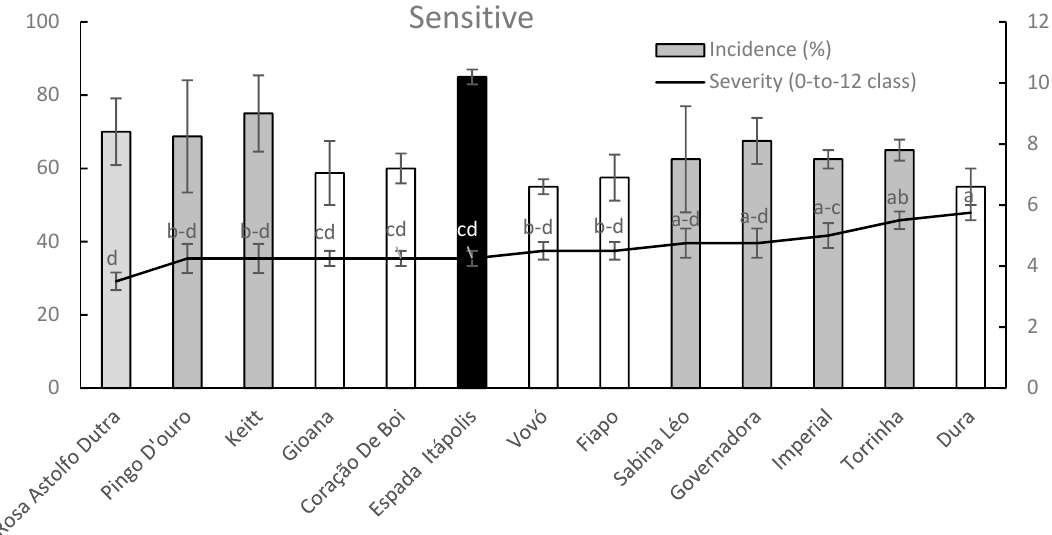
Figure 9. Column-line graphs on two axes comparing anthracnose incidence and severity caused by C. asianum within sensitive mango cultivars. Data ( ± SE values) were collected and analyzed as above done for previous figures. Grey colors of columns, as well as the absence of letters above points of the line, clearly shows the lack of significant differences according to both parametric and nonparametric approaches.